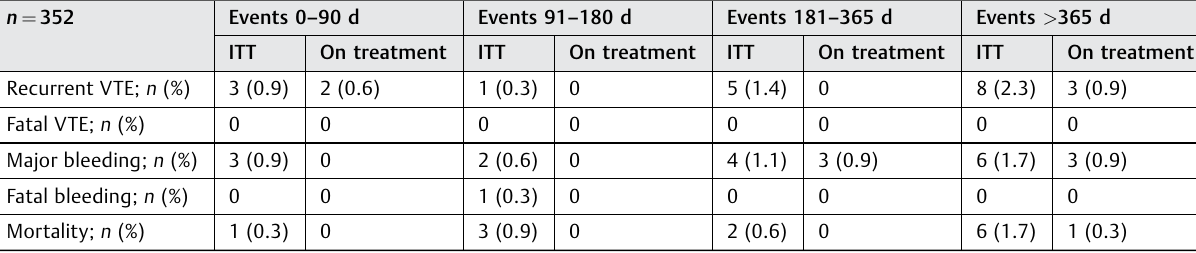
Table 2 Outcome event rates according to treatment phase and treatment continuation n ¼